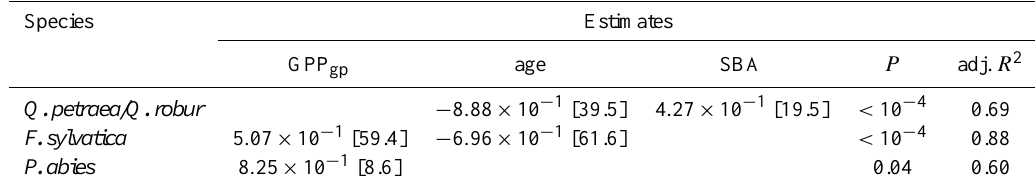
Table 4. Spatial dependences of the annual woody growth: multiple-regression estimates. Data have been centred and scaled. GPP gp is the gross primary production of the growth period, age is the average age of the stand, and SBA is the stand basal area (Table 2). Values: estimates [ F values]. All estimate values differed significantly from 0 ( P < 0 . 001). All variables were retained in the bootstrap procedure (see main